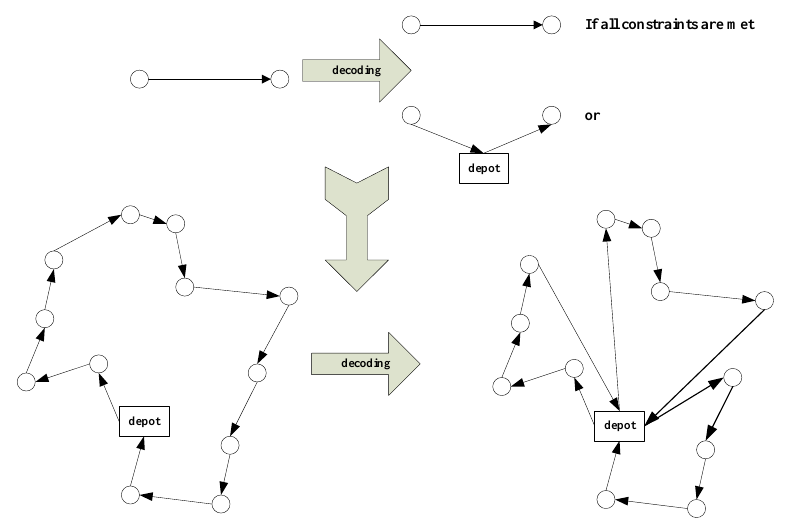
Figure 4. Decoder method based on model constraints. The position of the particle in each dimension is composed of two arcs adjacent to node d. δ , as show in Equation (21), represents the current dimension; nb 1 is the previous customer point; and , nb 2 is the next customer point. among them, nb 1 , nb 2 ∈ { 1, 2, . . . , δ − 1, δ + 1, . . . , m } , nb 1 (cid:54) = nb 2 .